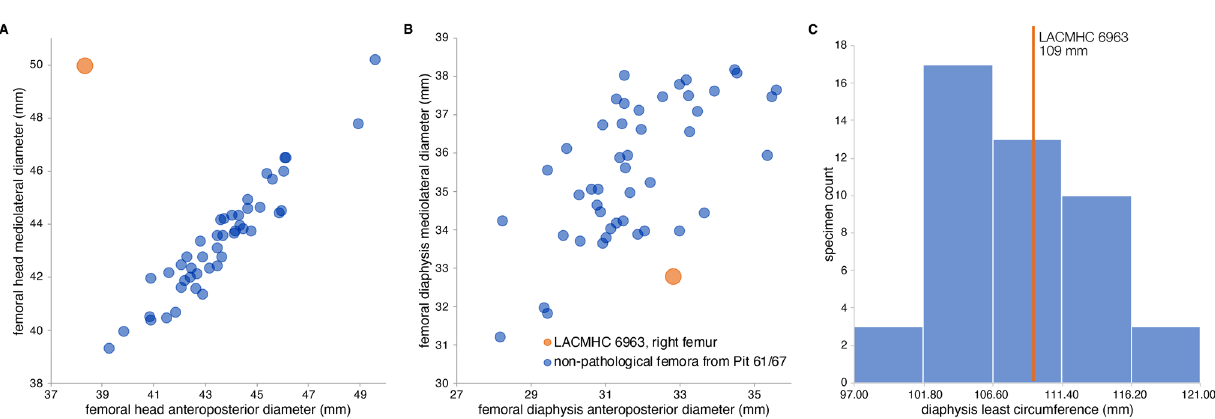
Figure 7. Metric data for the pathological Smilodon femur (LACMHC 6963) in comparison to non- pathological adult specimens also from Pit 61/67. Numeric values are in Supplementary Data S5. ( A ) Bivariate plot of mediolateral diameter against anteroposterior diameter of the femoral head. The femoral head of LACMHC 6963 is mediolaterally elongated and anteroposteriorly compressed compared to non-pathological specimens. ( B ) Bivariate plot of mediolateral diameter against anteroposterior diameter of the femoral diaphysis. The diaphysis of LACMHC 6963 is mediolaterally compressed relative to its anteroposterior diameter. ( C ) Histogram of femoral diaphysis least circumference, showing LACMHC 6963 (orange line) well within the range of non-pathological adult specimens and suggesting that the individual with the pathology also had reached adult